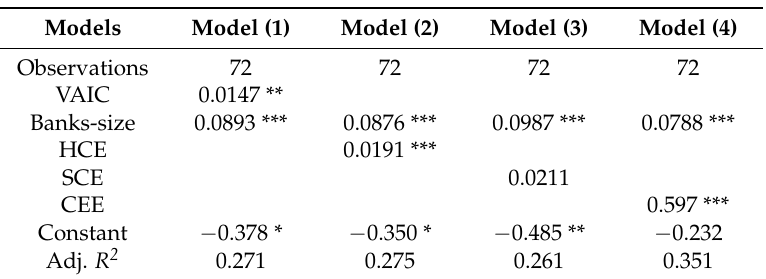
Table 3. Regression